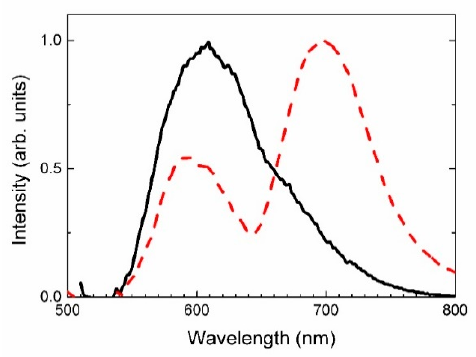
Figure 15. Photoluminescence spectrum of the fedorite samples Gav-43 (dashed red curve) and Irk-53 (solid black curve) under 405 nm excitation at 77 K.